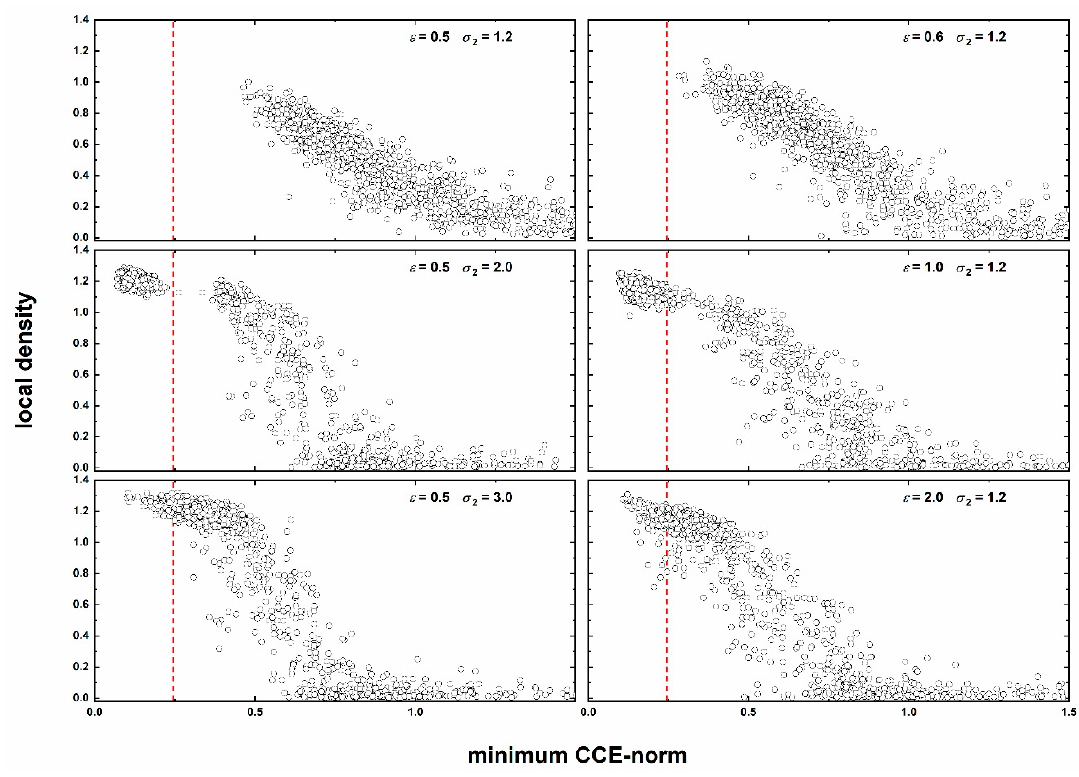
Figure 14. Parity plot of the local density as a function of the minimum CCE norm for all sites of the last recorded configuration for: ( top panel) amorphous, ( middle panel) crystal, and ( bottom panel) glassy SW chain clusters. The vertical red dashed line denotes the threshold value ( µ c = 0.245) for the identification of HCP, FCC or FIV local environments for non-overlapping spheres.